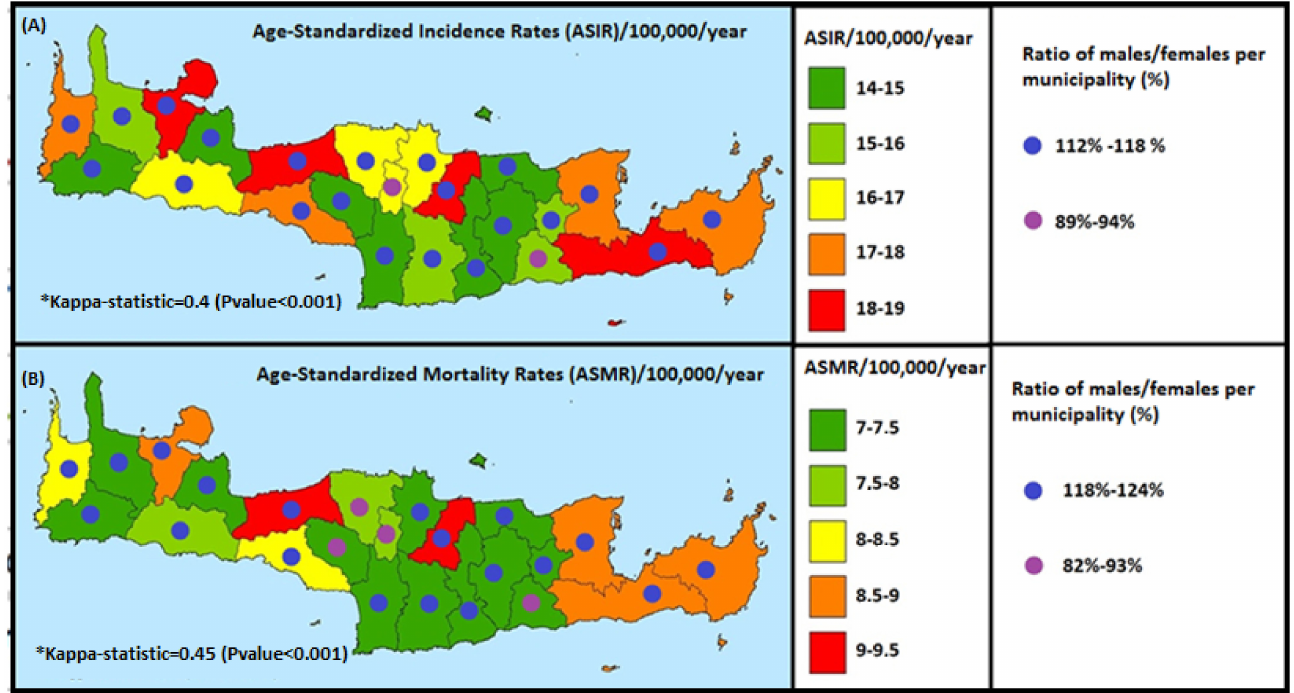
Figure 4. Gender-based distribution of Age-Standardized Incidence and Mortality Rates per 100,000 people/year for the time period of 1992–2017.